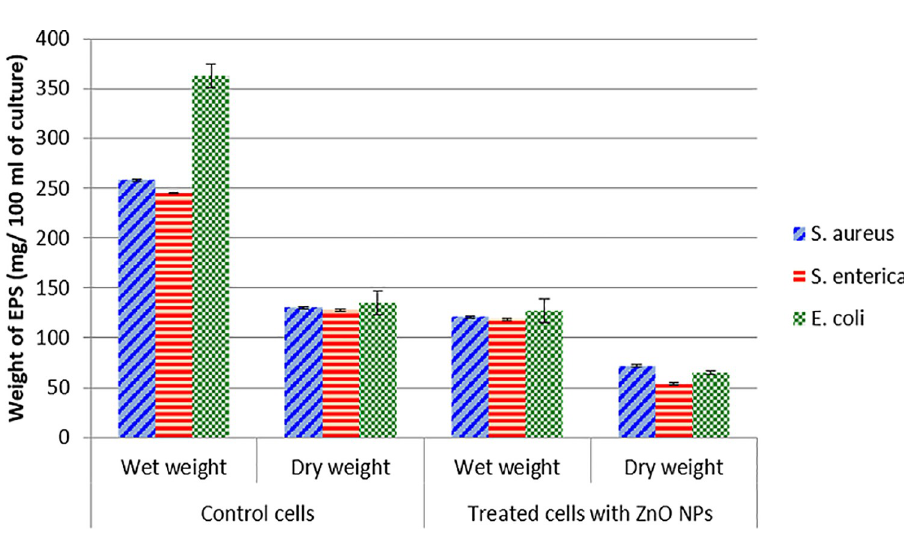
Fig 7. Quantification of EPS extracted from cells of antibiotic-resistant foodborne pathogens grown in the presence and absence of sub-inhibitory concentrations of green synthesized ZnO NPs. Values are presented as Mean ± Standard error; each experiment was performed in